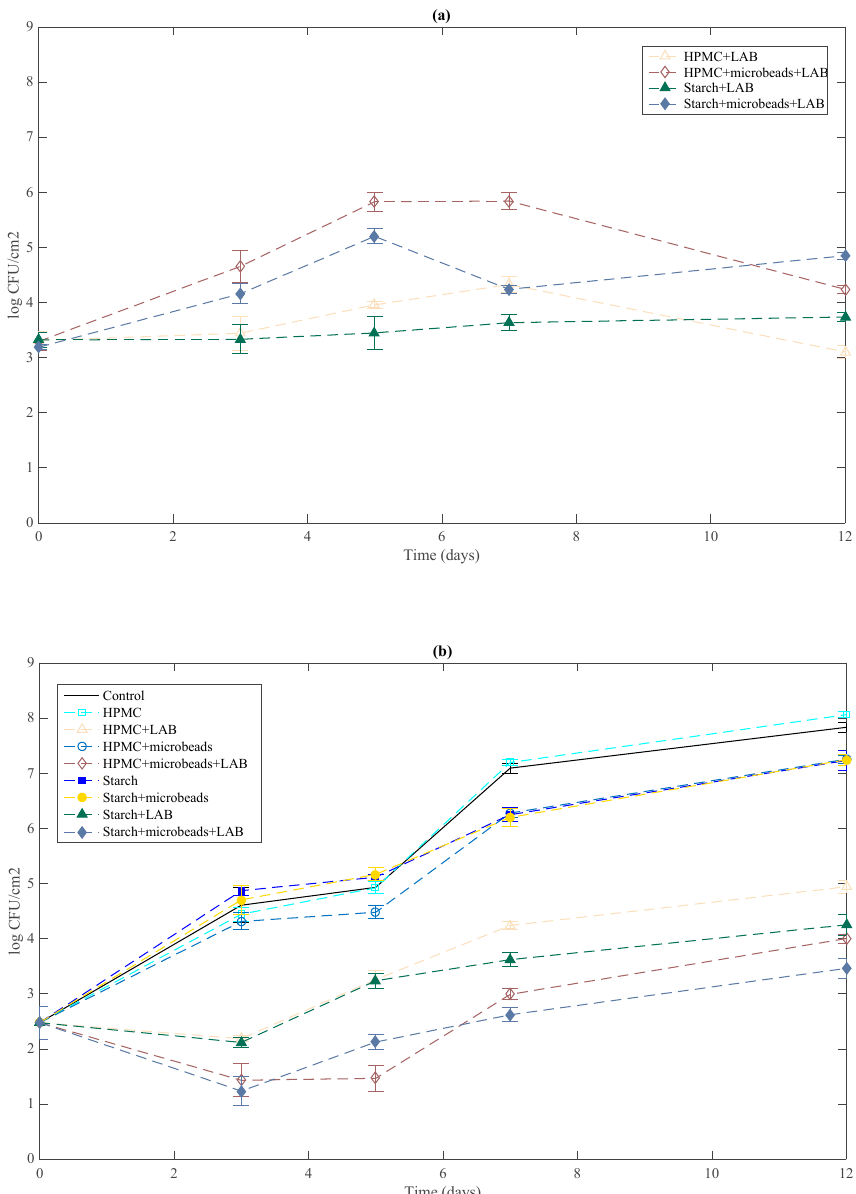
Figure 1. Effect of bioactive films on the growth of L. monocytogenes on TSA medium stored at 5 °C ( b ) and survival of LAB ( L. lactis ) in the film in contact with TSA ( a ). Mean values and standard deviation.